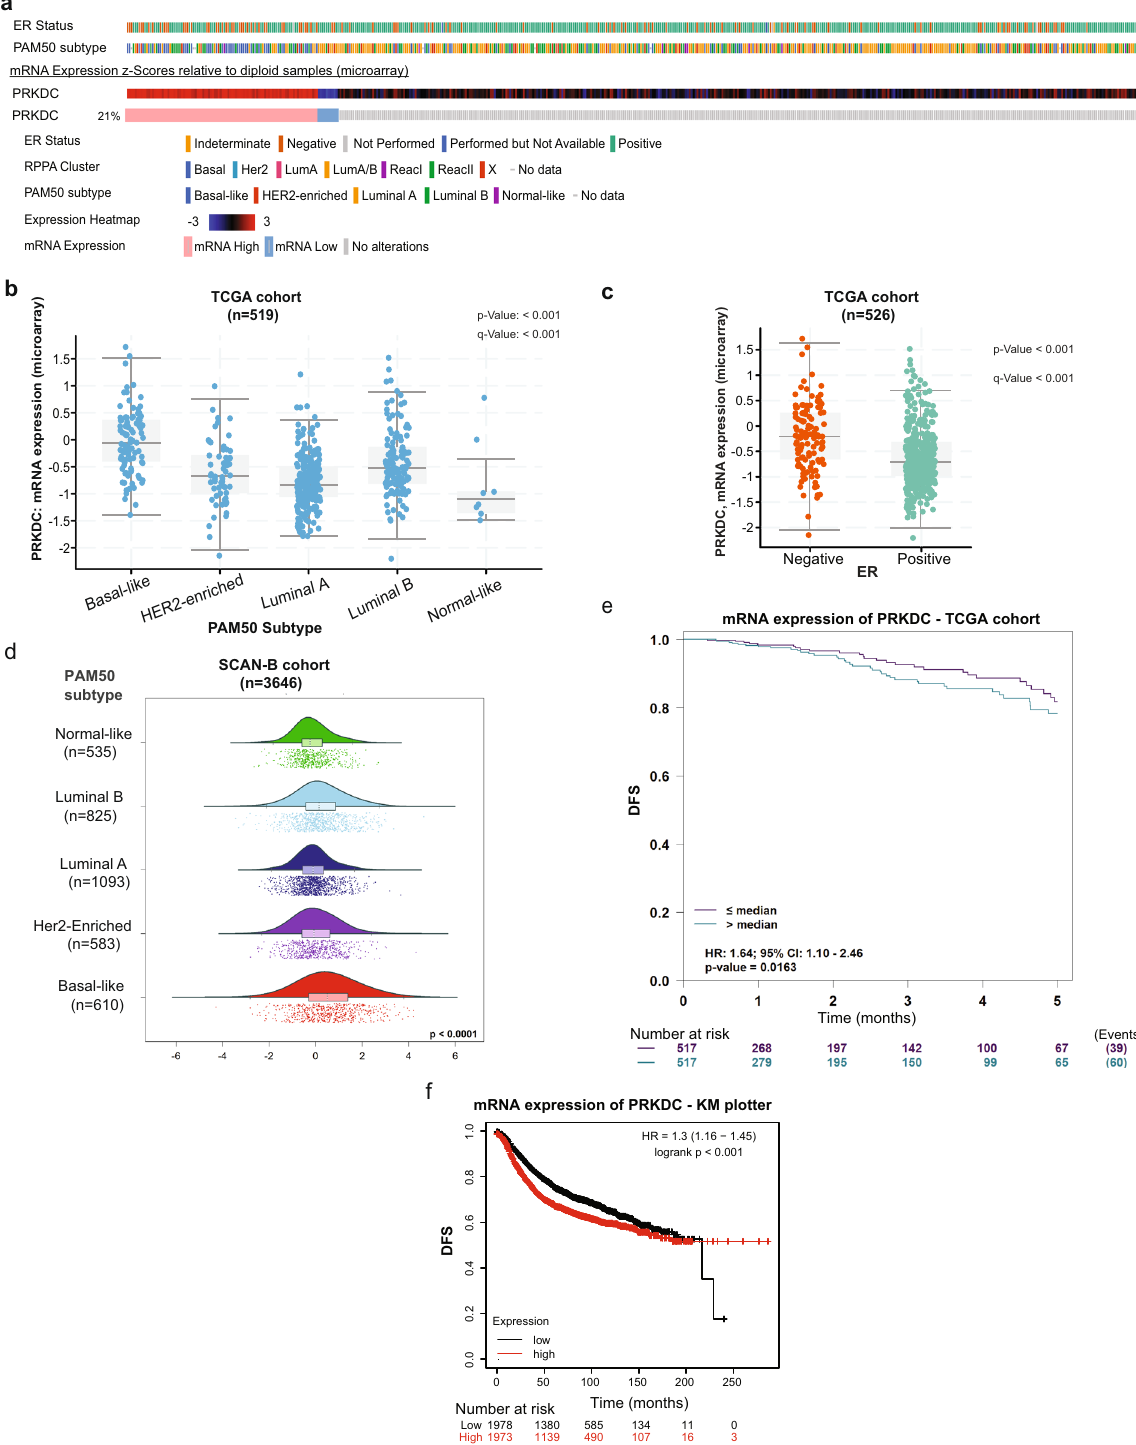
Fig. 6 Analysis of PRKDC expression using publicly-available breast cancer datasets. a Oncoprint outlining the biological classi fi cations of 825 cases included in the TCGA invasive breast cancer cohort according to ER status, PAM50 subtype, RPPA cluster, and PRKDC mRNA expression as determined by microarray. b – c Boxplots showing the expression levels of PRKDC , as derived from microarray in the TCGA invasive breast cancer cohort, is signi fi cantly associated with basal-like PAM50 intrinsic subtype. The median (center bar), and the third and fi rst quartiles (upper and lower edges, respectively) are shown. c Data were obtained through the cBioPortal for Cancer Genomics database 74 . d Raincloud plots showing the expression level of PRKDC, as derived from RNA-seq on the SCAN-B breast cancer cohort, is signi fi cantly associated with basal-like PAM50 intrinsic subtype. e – f Kaplan – Meier survival curves showing the association between PRKDC expression and DFS on cases from the TCGA invasive breast cancer cohort ( e ) and 35 Gene Expression Omnibus breast cancer datasets ( f ). Plots were generated using the bc-GenExMiner v4.5 75 and the KMplotter analysis platform curated from 35 Gene Expression Omnibus breast cancer datasets 41 . Abbreviations: ER estrogen receptor, IHC immunohistochemistry, DFS disease-free